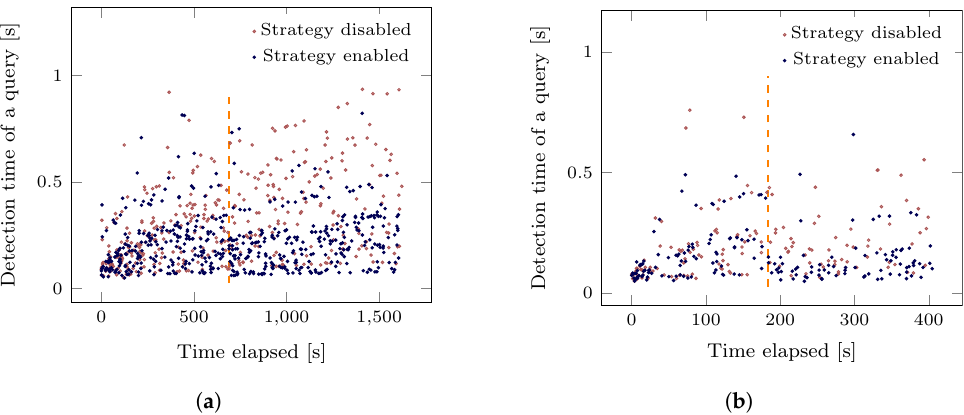
Figure 9. Detection time of u 2 ’s and u 8 ’s queries with and without the user-oriented partitioning strategy. The orange dashed line depict the time at which the user has been affected its own part of the QHL. ( a ) u 2 ’s queries. ( b ) u 8 ’s